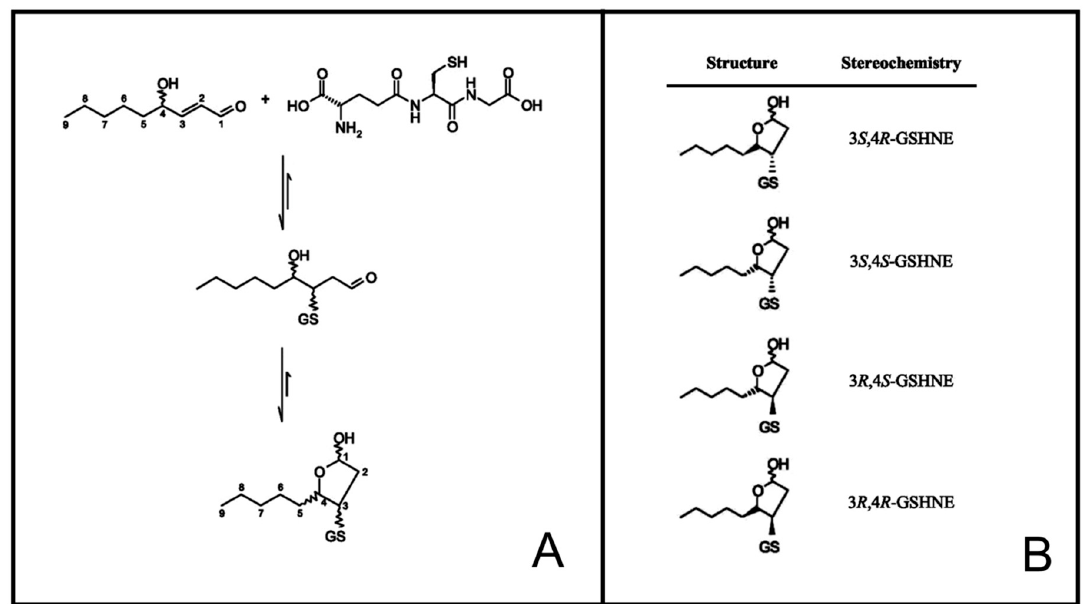
Figure 1. Reaction of 4-hydroxy-2-nonenal (HNE) with glutathione (GSH). ( A ) The reaction of GSH adduction on C3 of HNE followed by intramolecular cyclization to generate the corresponding hemiacetal species. ( B ) The structures of different 3-glutathionyl-4-hydroxynonane (GSHNE) diastereoisomers generated upon adduction.